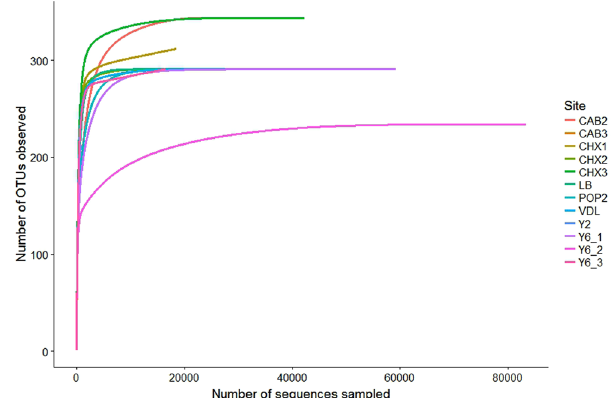
Figure 2. Rarefaction analysis of the extreme hyper-arid and hyper-arid OTUs at 94.5–97% phylogenetic